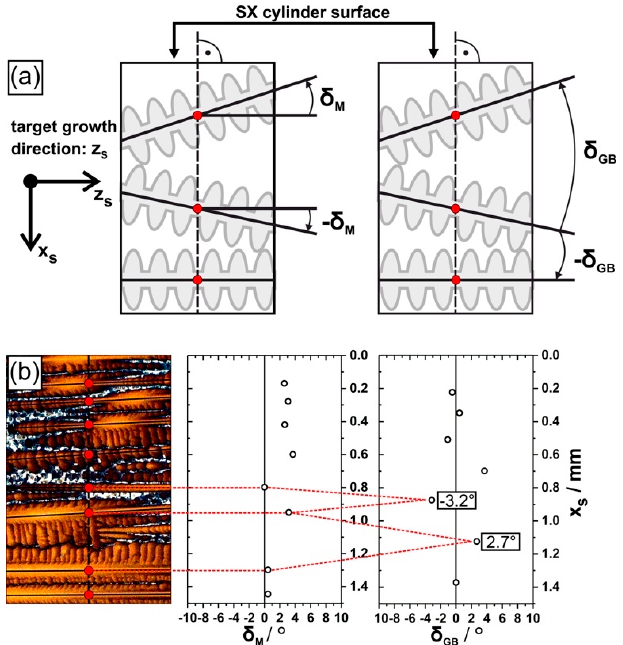
Figure 3. Evaluation of dendrite growth directions. ( a ) Determination of projected dendrite growth directions and projected angles between adjacent dendrites. ( b ) Example for quantification of in-plane dendrite misorientations.